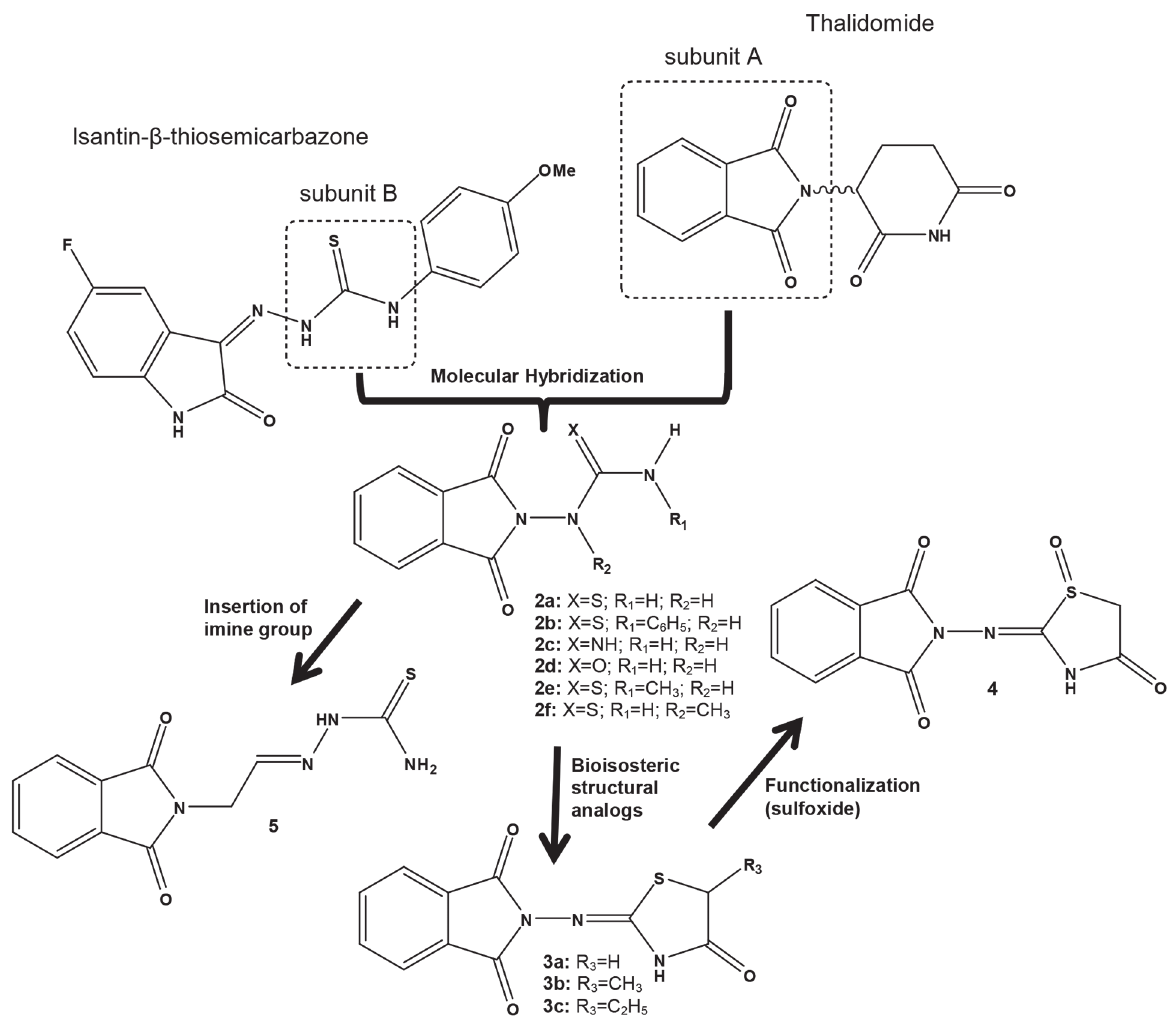
Figure 1 - Our design concept of antitumor and immunomodulatory drugs exploring the molecular hybridization of the prototypes Thalidomide and